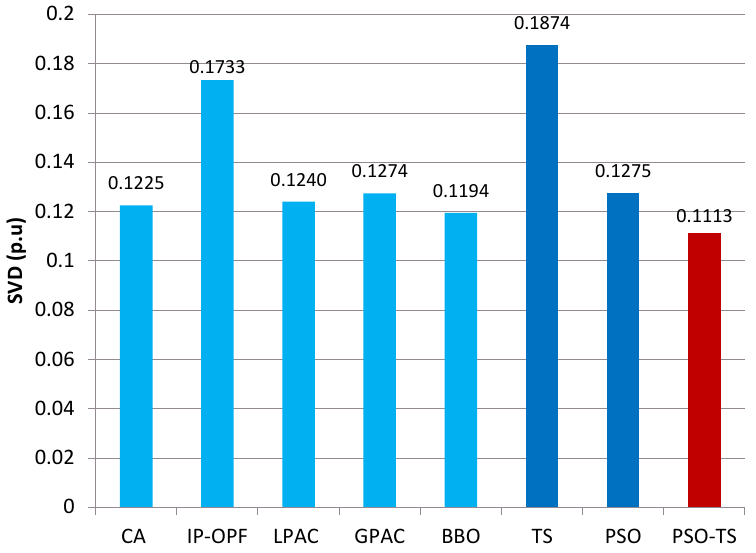
Figure 7. Convergence characteristic of the voltage deviation objective (SVD) (Case 1).